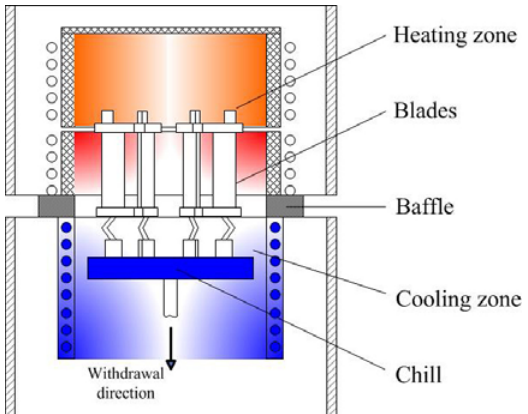
Figure 1. Schematics of a Bridgman